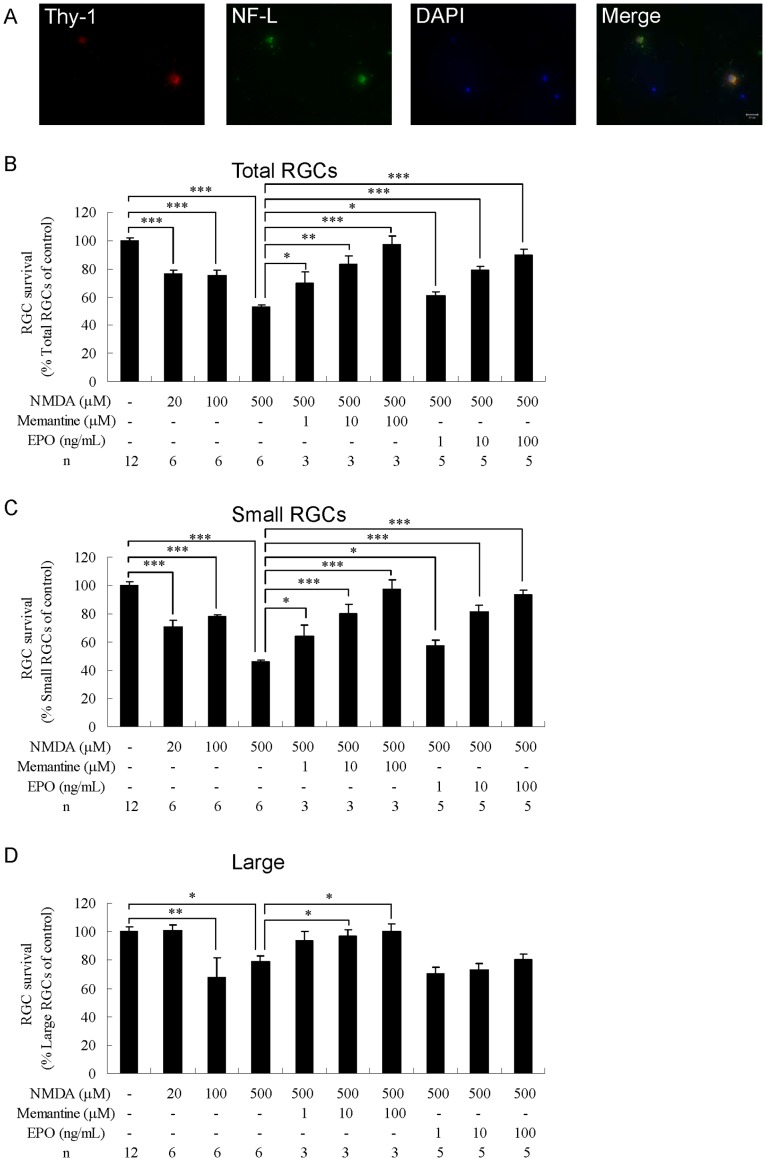
Effects of erythropoietin on total, small, and large RGCs under NMDA-induced toxicity.(A) Morphology of NMDA-treated RGCs. The cells were cultured in a medium supplemented with 500 µM NMDA. After culturing, RGCs were immunostained with anti-Thy-1 antibody (red) and anti-NF-l antibody (green), and DAPI nuclear staining (blue). Survival rate of (B) total, (C) small, and (D) large RGCs. The cells were treated with vehicle: NMDA (20–500 µM) alone, NMDA (500 µM)+memantine (1–100 µM), or NMDA (500 µM)+EPO (1–100 ng/mL). The number of RGCs was counted and normalized versus the control group. Data are presented as mean ± standard error of the mean (n = 3–12). Data were statistically analyzed by 1-way ANOVA, followed by the Dunnett’s test. *P<0.05, **P<0.01, and ***P<0.001.